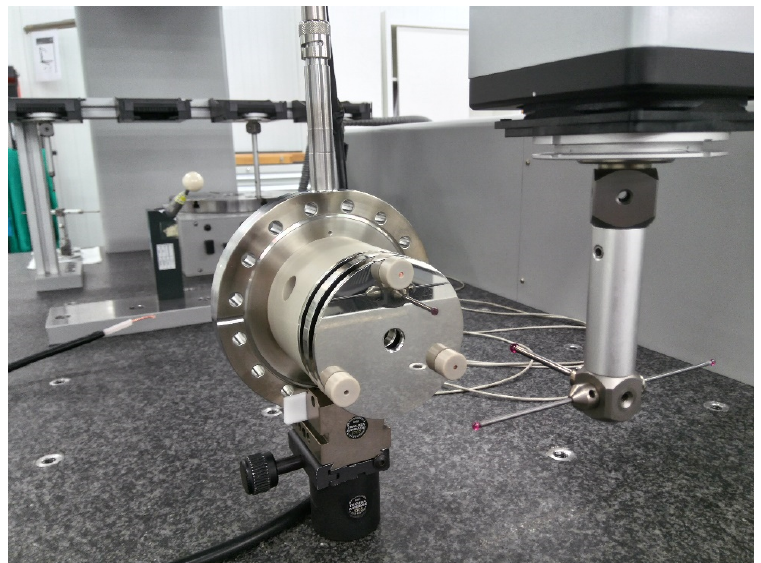
Figure 3. Einzel lens for the ECR ion source for LINAC 7 being measured after final assembly using a Zeiss coordinate measuring machine at